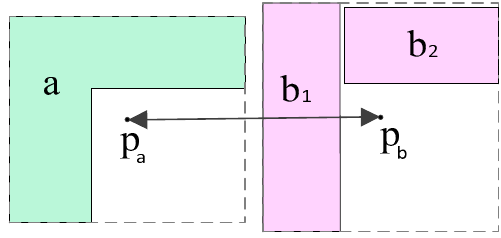
Figure 1. Distance between MBR centers of 𝒂 and 𝒃 .